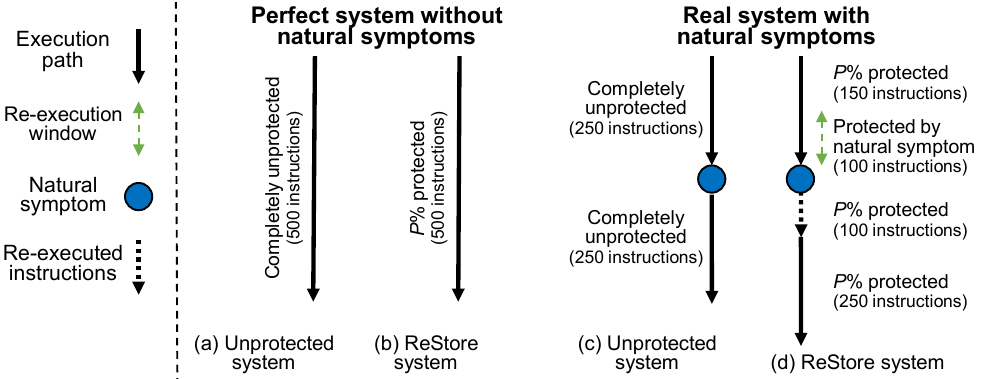
Figure 4. Coverage provided by the ReStore architecture on a system without and with natural symptoms. In the first case, the protection of the ReStore architecture is P , which is the probability that a failure-inducing soft error generates a symptom quickly after its occurrence. Even in the case of systems with natural symptoms, the coverage of ReStore remains the